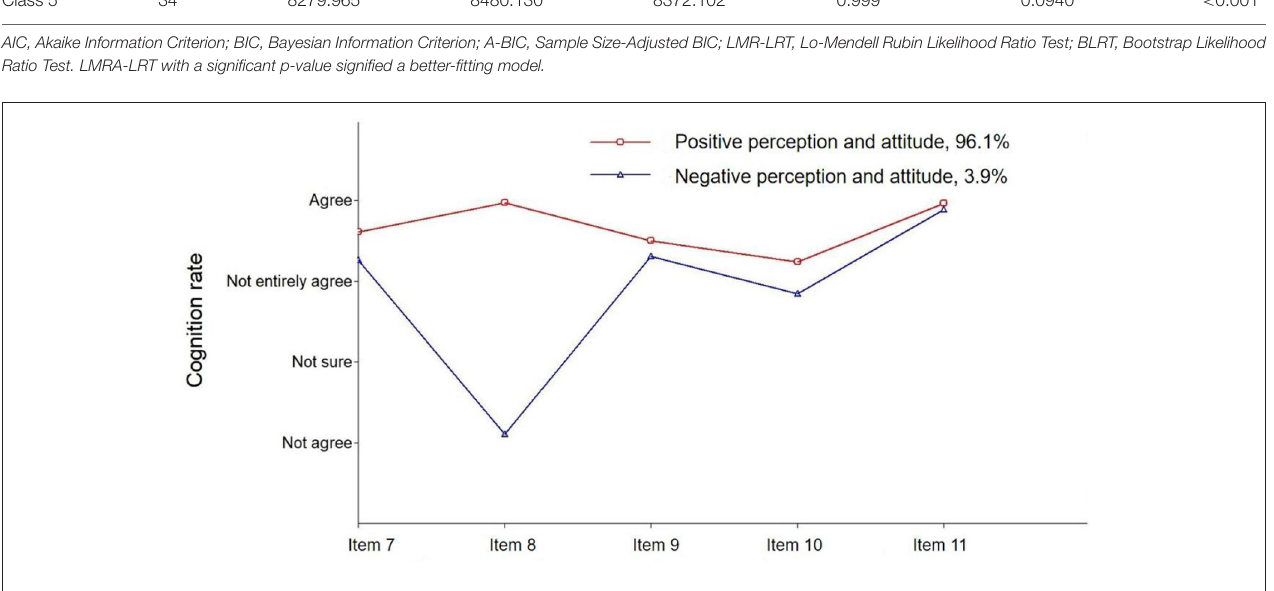
FIGURE 1 | Latent class profile related to the perceptions and attitudes towards